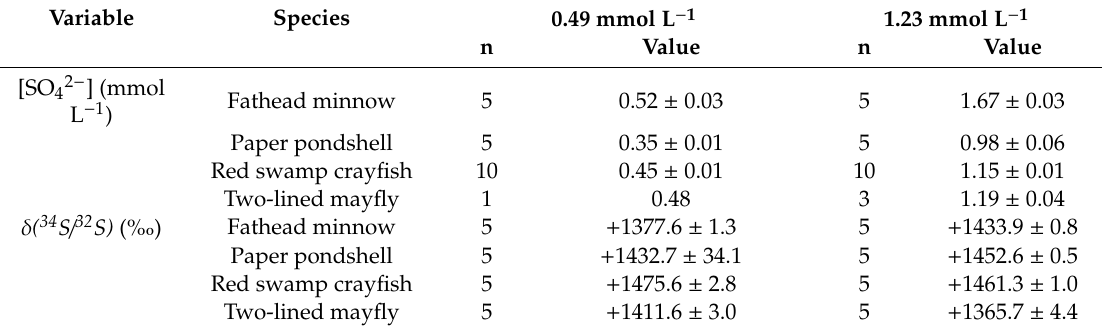
Table 2. Measured initial characteristics of SO 42 − in the test water for each species exposure. The column headings are the nominal concentrations of SO 42 − . The values are the sample mean ± 1 standard error. [SO 42 − ] (mmol L − 1 ) is the concentration of SO 42 − , and δ ( 34 S / 32 S) (% (cid:24) ) is molar ratio of 34 S / 32 S of the SO 42 −